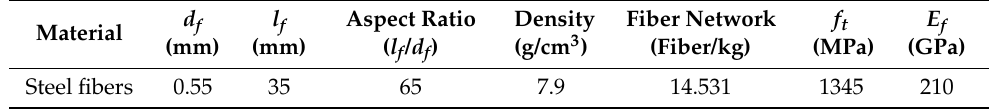
Table 3. Properties of steel fibers (as provided by the manufacturer [70]).